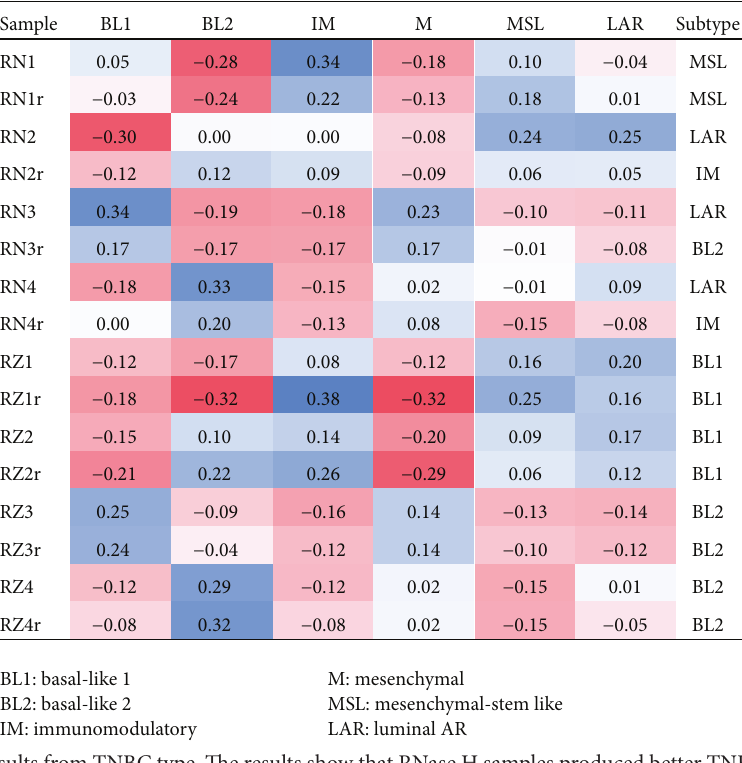
Figure 2: TNBC subtype results from TNBC type. The results show that RNase H samples produced better TNBC subtype consistency than Ribo-Zero samples.